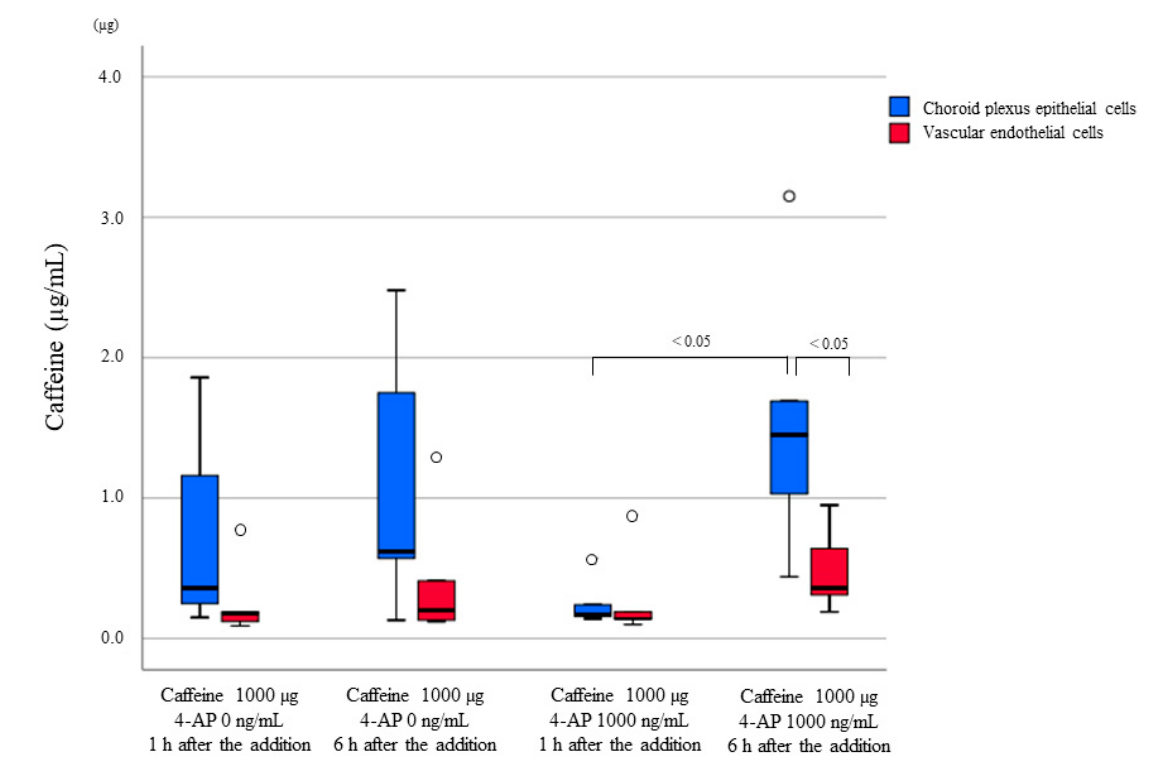
Figure 6. Concentrations of caffeine in vascular endothelial cells and in choroid plexus epithelial cells. Under all conditions, the concentration of caffeine is higher in choroid plexus epithelial cells than in vascular endothelial cells. In particular, a significant difference in caffeine concentration is observed 6 h after 1000 ng/mL 4-AP was added. Table 3. Caffeine concentrations (µg/mL) in vascular and choroid plexus epithelial cells at different time points after the addition of caffeine and 4-AP.